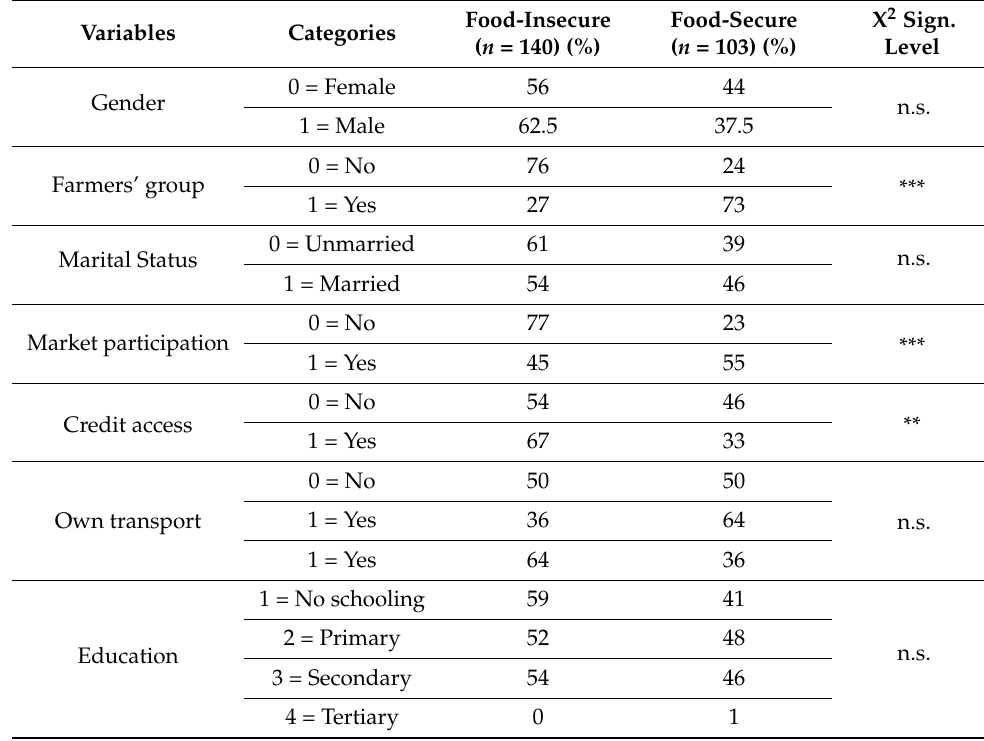
Table 4. Association between food security and socioeconomic